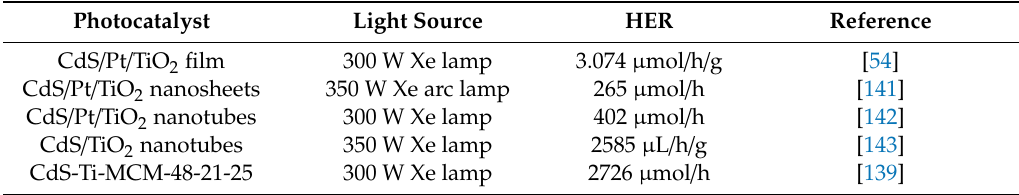
Table 10. ThephotocatalyticperformanceofH 2 generationinsomerelatedTiO 2 /